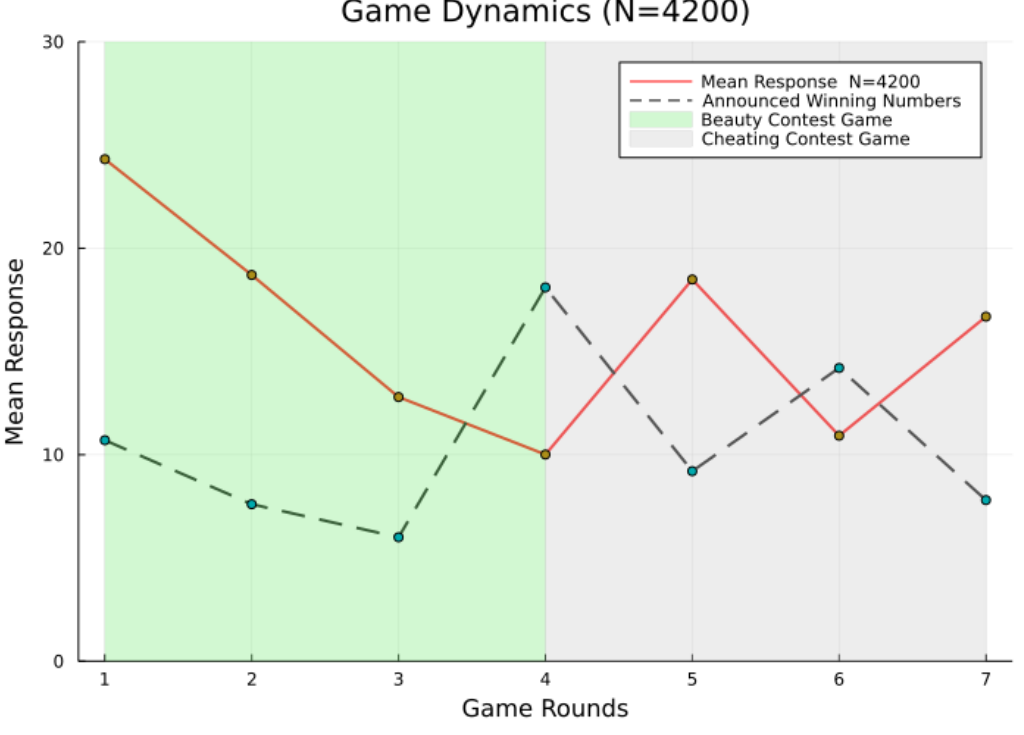
Figure 2. Output of experimental